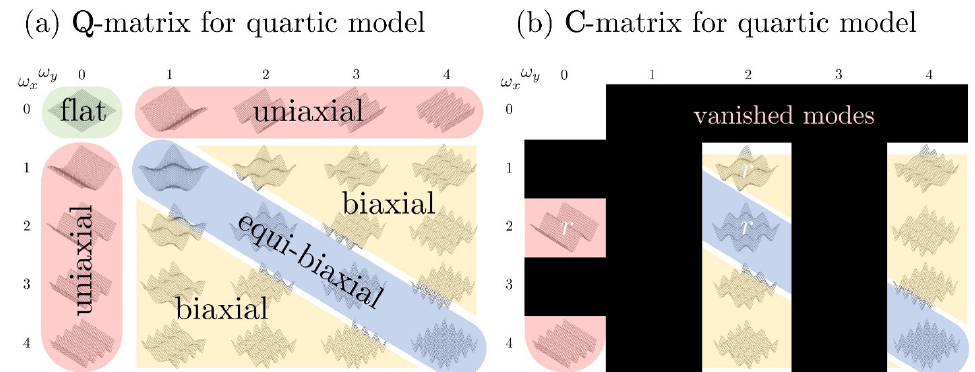
Figure 5. Visualization of the general shape Q - and C -matrix in Equations (13) and (15). The position of the wrinkling mode in Figure 5 exactly corresponds to the entry in the Q - and C -matrix. The red zone, blue zone, and yellow zone demonstrate uniaxial wrinkling, equibiaxial wrinkling and biaxial wrinkling, respectively. ( a ) The Q -matrix presents all possible wrinkling modes in a quartic model; ( b ) the C -matrix indicates that only 10 wrinkling modes are presented in this model due to the symmetry of the adopted director